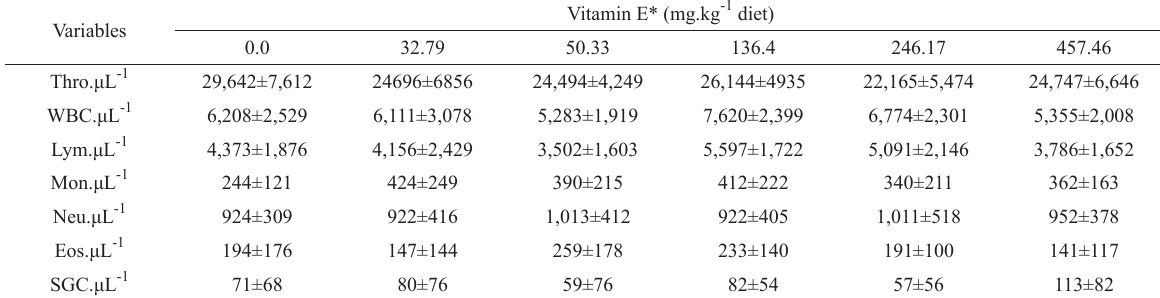
Hematological parameters (μ ± SD) of juvenile pacu P. mesopotamicus supplemented with increasing levels of dietary vitamin E.